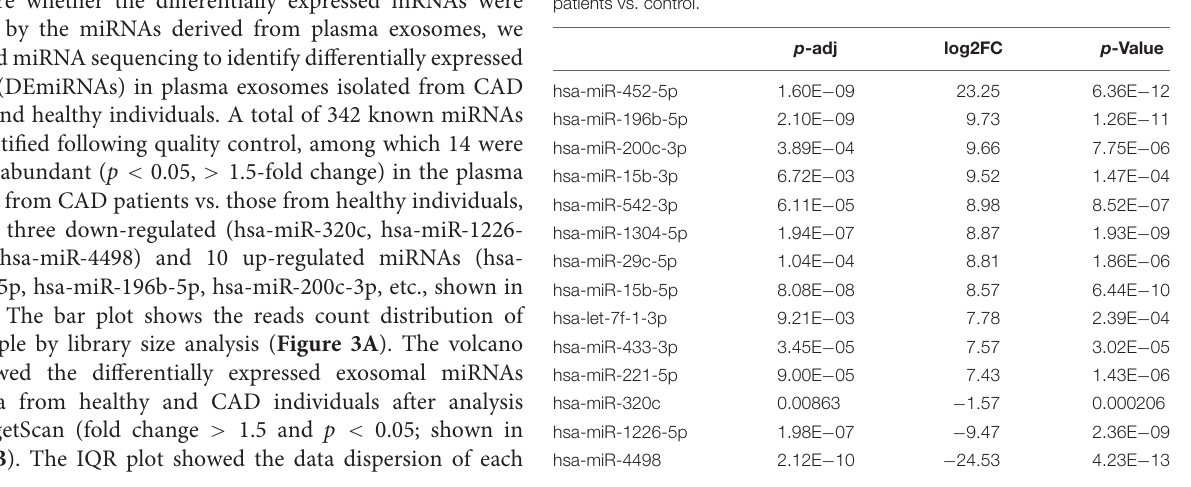
TABLE 4 | DEmiRNAs in exosomes from coronary artery disease patients vs.